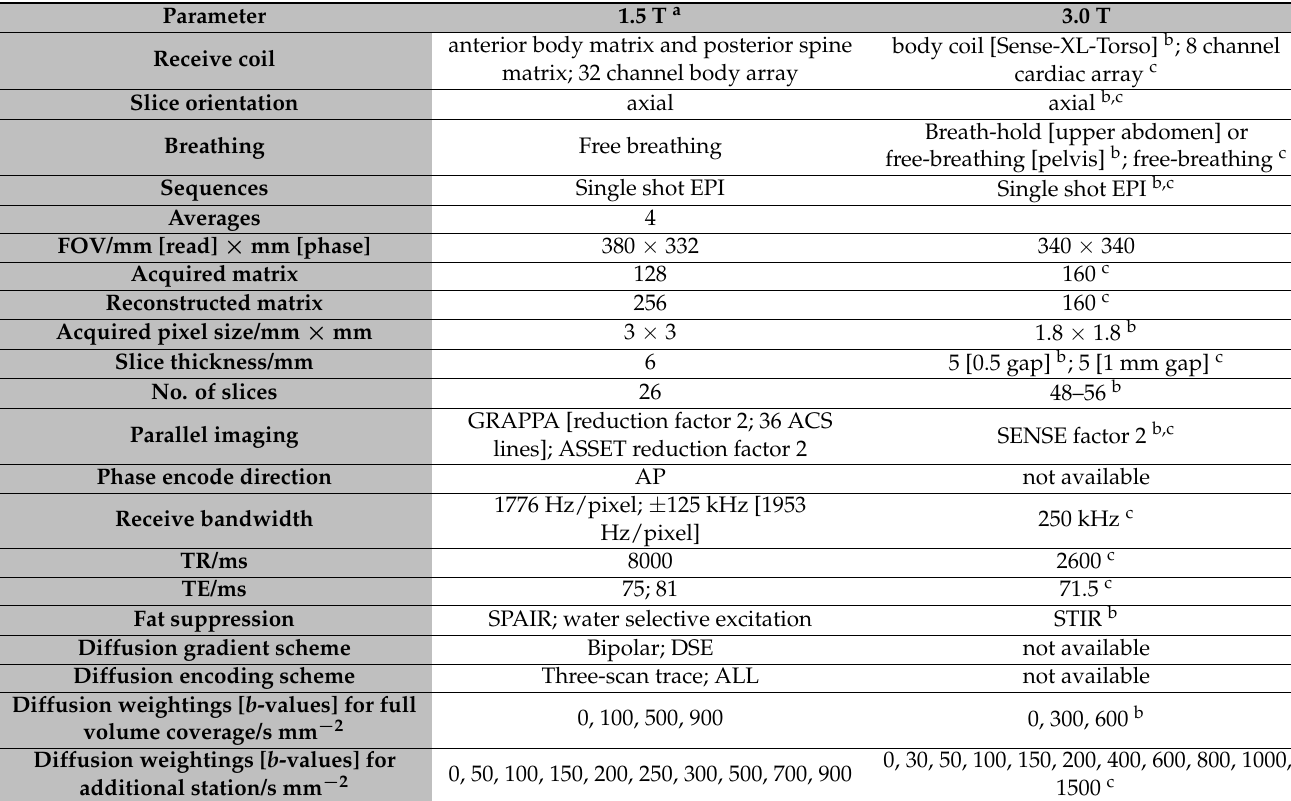
Table 1. Pulse sequence parameters used at 1.5 T and 3.0